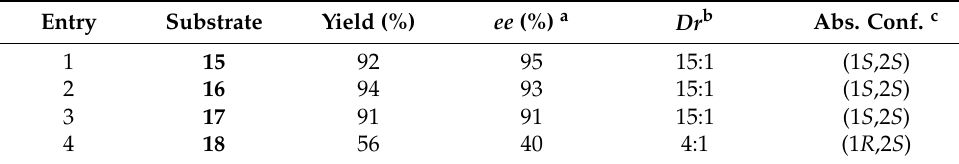
Scheme 3. Asymmetric cyclopropanation reaction of alcohols 15 – 18 catalyzed by aziridine-phosphine 6 (*—stereogenic center). Table 2. Asymmetric cyclopropanation promoted by aziridine-phosphine 6 .